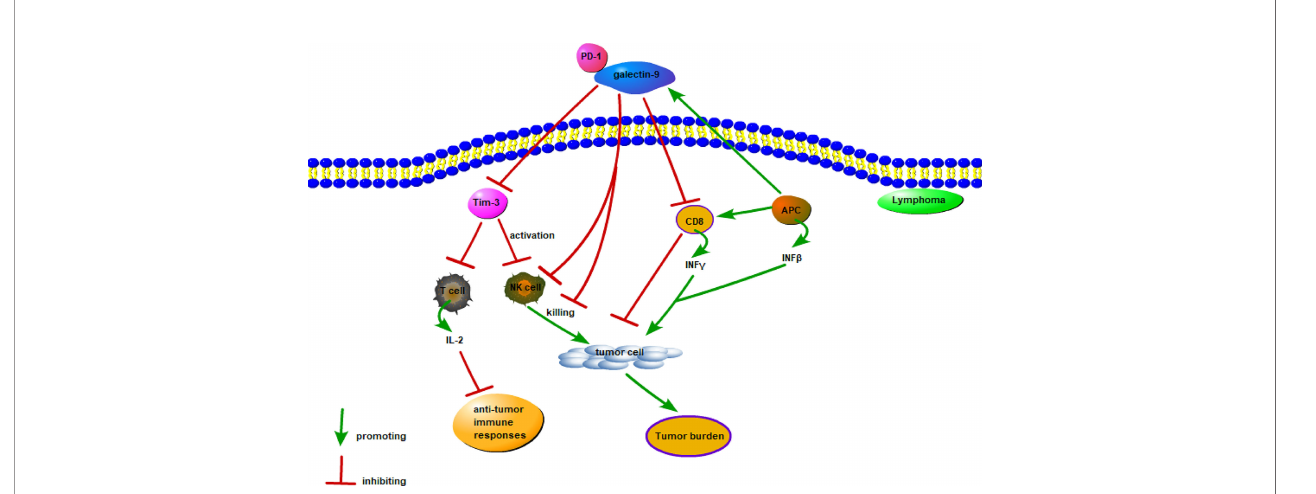
FIGURE 4 | Possible mechanism of galectin-9 in lymphoma. Galectin-9 mainly exerts a pro-tumor effect by binding to Tim-3, Tim-3 inhibits the cytotoxic IL-2 secreted by T cells and inhibits the lethality of NK cells, and the combination of PD-1 and galectin-9 weakens the work of Gal-9/Tim-3. Interferon-induced expression and secretion of galectin-9 is a potential mechanism for tumor-acquired immune resistance. INF b produced by APC and tumor cells and INF g produced by activated CD8 T cells induce APC and tumor cells to express and secrete galectin-9. However, galcectin-9 induces T cell death and inhibits the anti-tumor immune